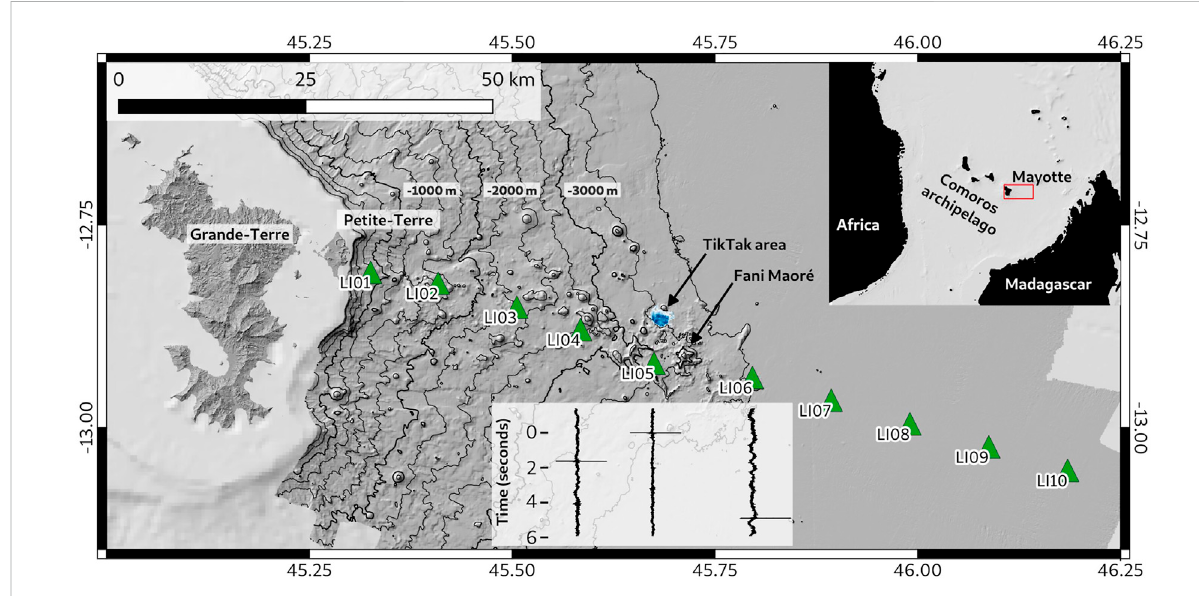
Bathymetry (Feuillet etal.,2019)oftheeasternMayottesubmarinevolcanic areawithdepthcontoursevery 1000 m(thick contours)and250 m (light contours). The green triangles represent the line of OBS deployed from October 7 to October 17, 2020. The new volcanic edi fi ce (Fani Maoré) lies at the eastern tip of the volcanic chain, close to LI05. The TikTak volcanic area, active during the deployment, is shown in blue. Top right insert: regional setting of the Comoros archipelago, north of Mozambique Channel, between Africa and Madagascar. Insert below the stations: example of an hydro-acoustic event recording, synchronized with LI05 fi rst